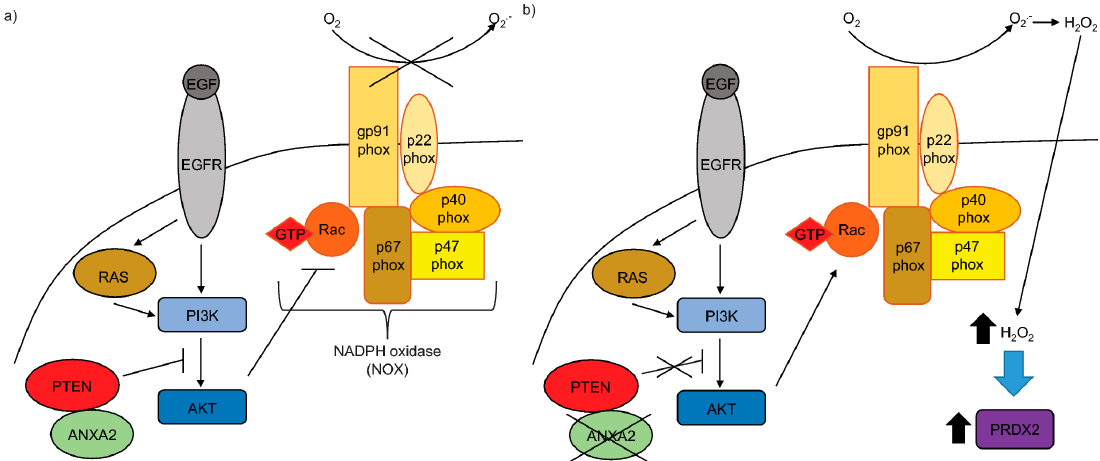
Figure 6. Proposed model for ANXA2 regulation of AKT activation. ( a ) ANXA2 binds to and positively regulates the activity of PTEN. This mechanism might play a role in the regulation of H 2 O 2 -dependent signaling, e.g., EGFR/EGF or RAS, leading to inactivation of the PI3K/AKT signaling pathway. ( b ) In the absence of ANXA2, PTEN activity is inhibited leading to enhanced AKT activation. The activation of the EGFR/PI3K/AKT or RAS/PI3K/AKT signaling pathways enable Rac to bind and activate NADPH oxidase (NOX), ultimately leading to the production of H 2 O 2 . Increase in intracellular H 2 O 2 levels induce PRDX2 up-regulation.